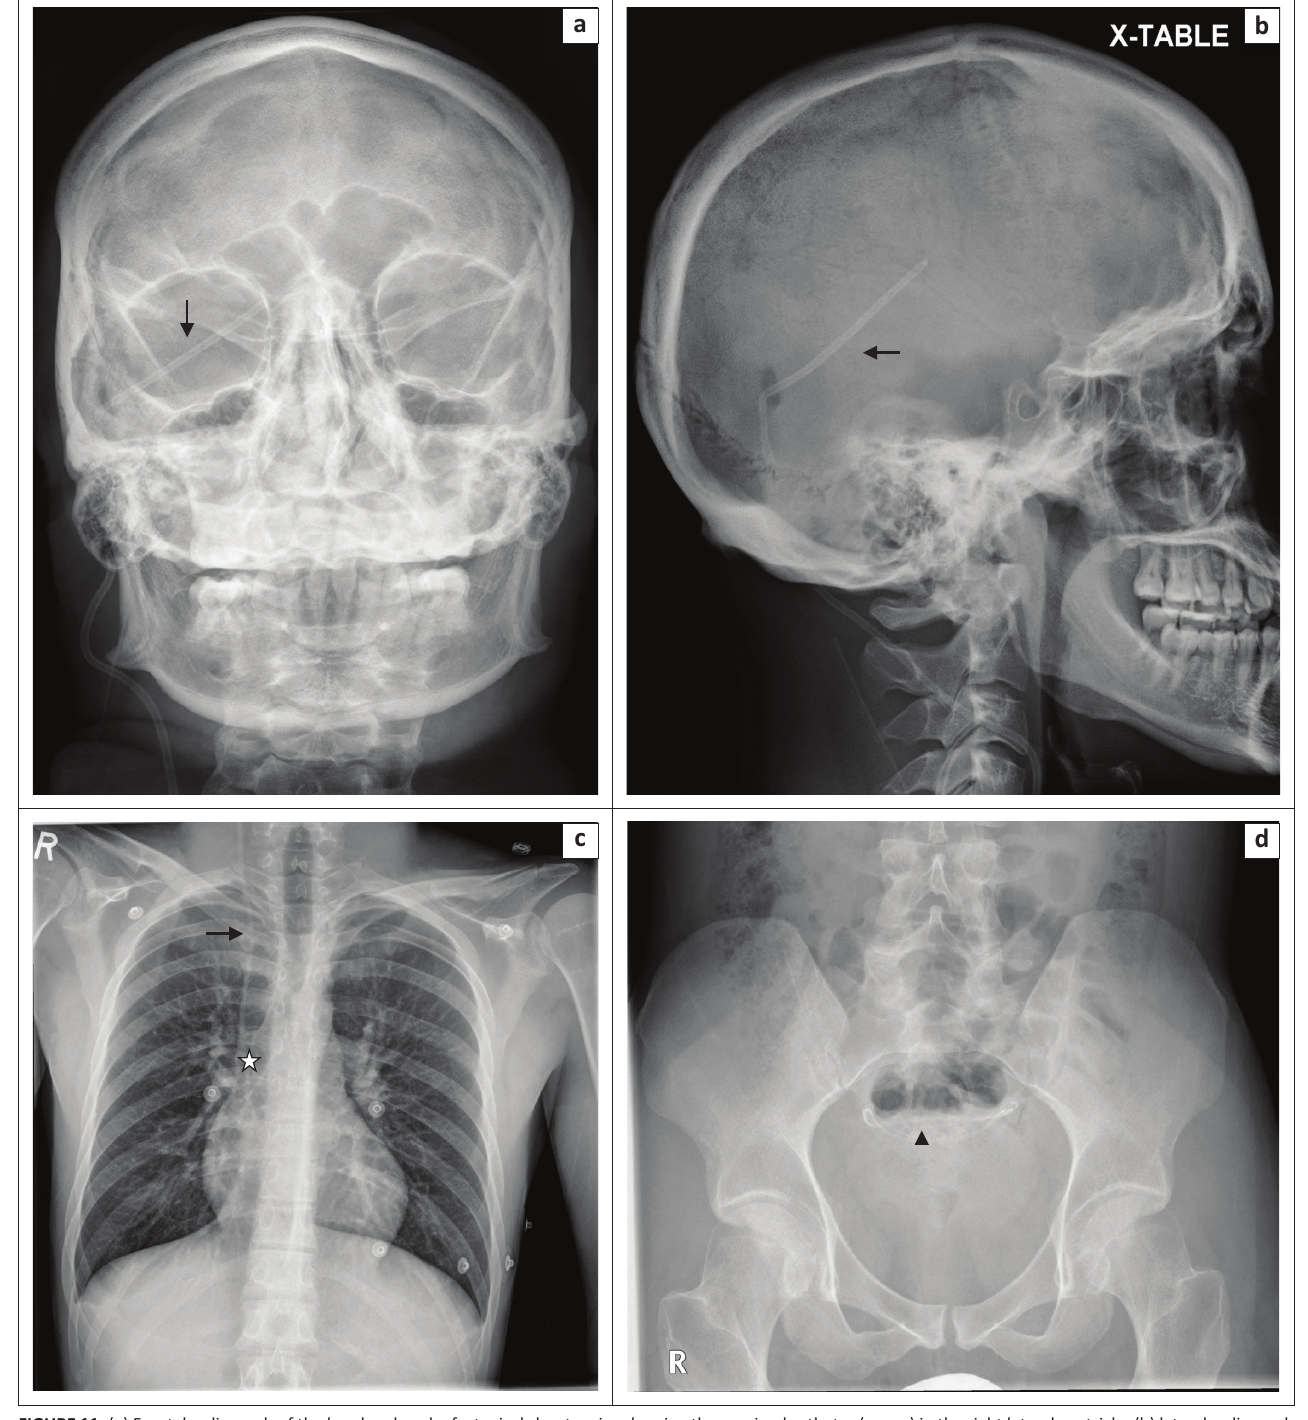
FIGURE 11: (a) Frontal radiograph of the head and neck of a typical shunt series showing the proximal catheter (arrow) in the right lateral ventricle; (b) lateral radiograph of the head and neck of a typical shunt series showing the proximal catheter (arrow) in the lateral ventricle; (c) chest radiograph of a typical (ventriculoatrial) shunt series showing the distal catheter (arrow) terminating at the cavoatrial junction (star) and (d) magnified image of an abdominal radiograph showing an abandoned ventriculoperitoneal shunt catheter in the pelvis